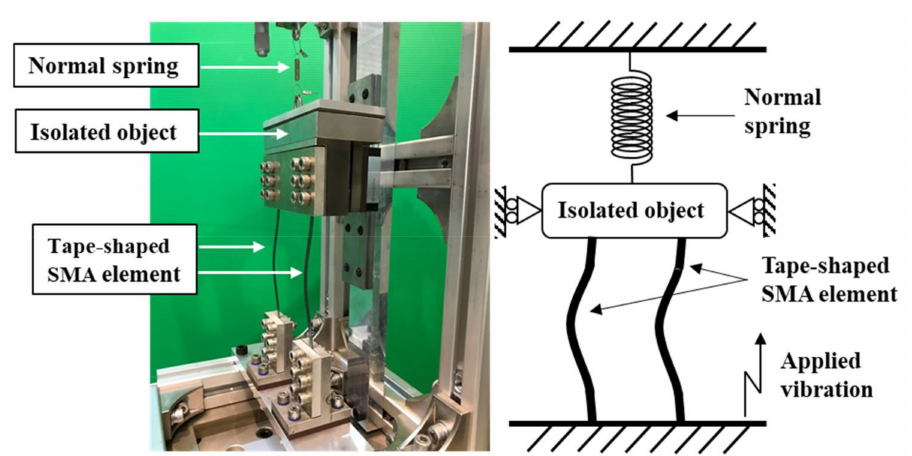
Figure 2. Photograph and schematic drawing of the passive vibration isolator using tape-shaped SMA